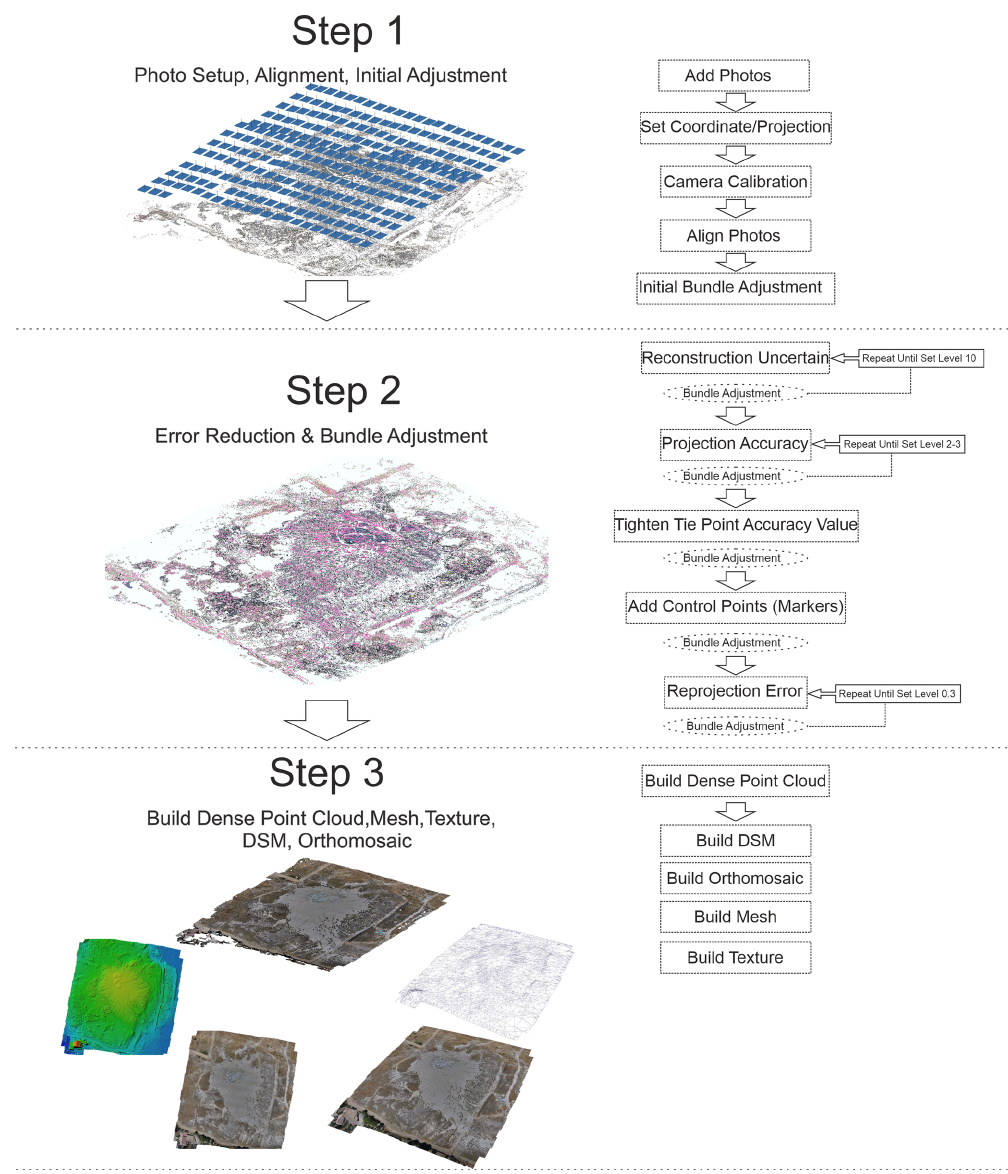
Figure 6. Simplified block diagram of the photogrammetric processing chain.